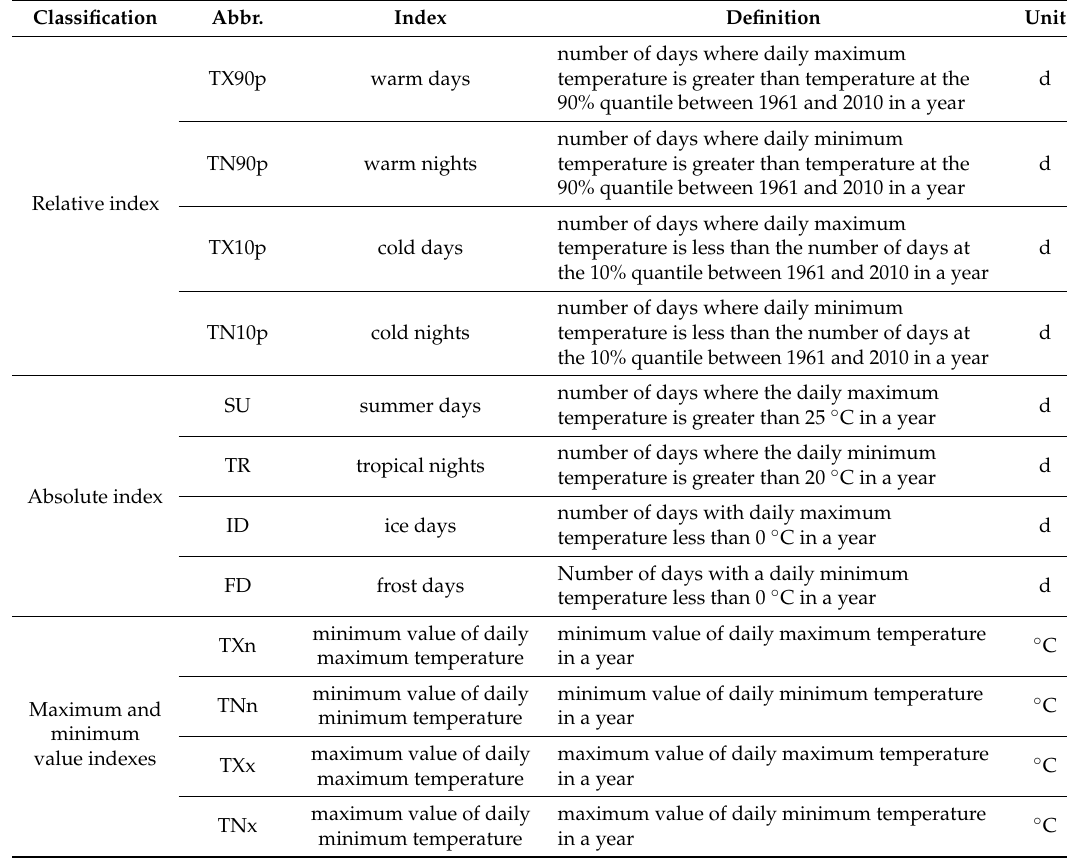
Table 1. Extreme temperature